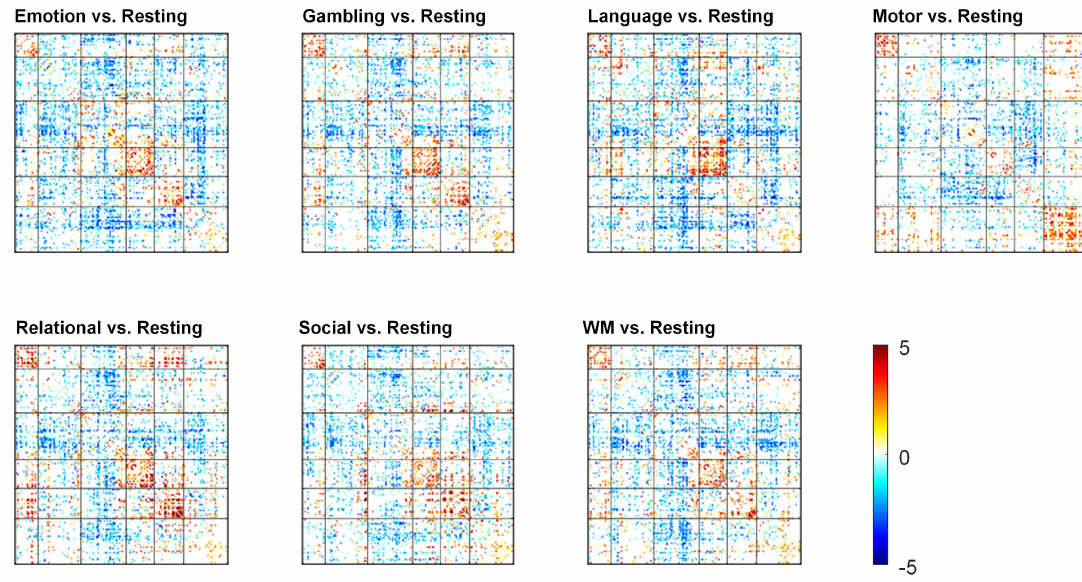
Figure A3. The detailed t values of the distinguished connections for each pair of brain states.